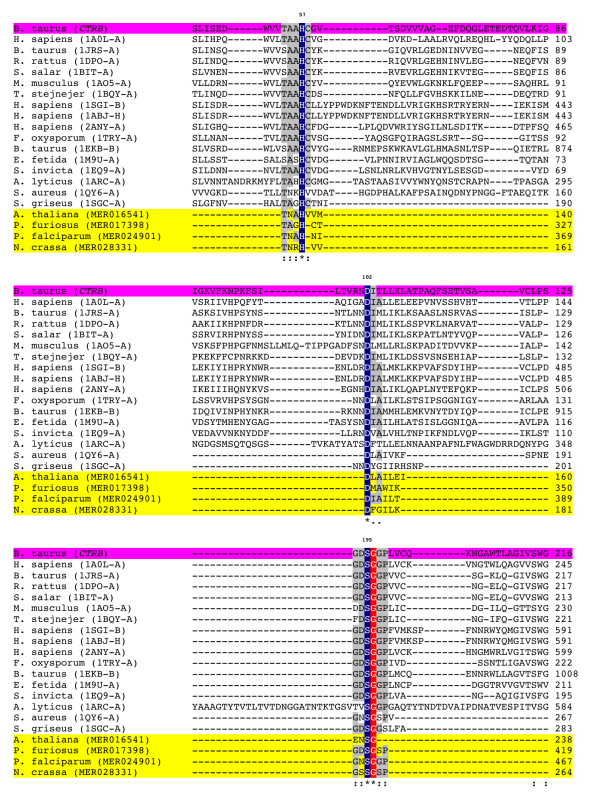
Multiple amino acid sequence alignment of PA serine proteases. CLUSTALW was used to align amino acid sequences of PA serine proteases for which their structures were determined experimentally or predicted computationally (highlighted in yellow). Bovine chymotrypsin B (CTRB, highlighted in magenta) is used as a standard reference for residue numbering. Only the regions showing the conserved catalytic residues His (H), Asp (D) and Ser (S) are shown. Amino acid residues with 100% conservation (*) between aligned sequences are either highlighted in blue (catalytic residues) or red (other). Other residues showing high (:) conservation (highlighted in gray) or medium (.) conservation are also indicated.